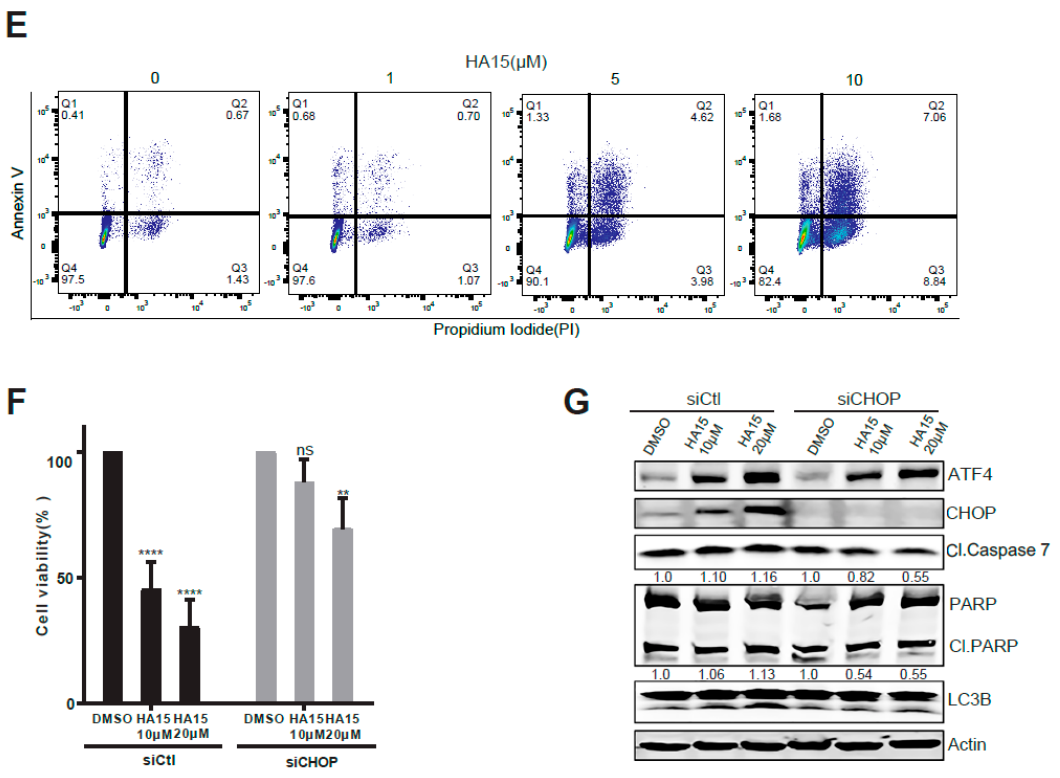
Figure 4. Activation of malfunctional UPR underpins HA15 efficacy in MPM cells. ( A , B ) qRT-PCR of MESO-1 cells after treated with HA15 (10 uM) for the indicated time points. Data are presented as mean ± s.d. ( n = 3). * p < 0.05, ** p < 0.01, *** p < 0.005, and **** p < 0.0001 by two-way ANOVA with